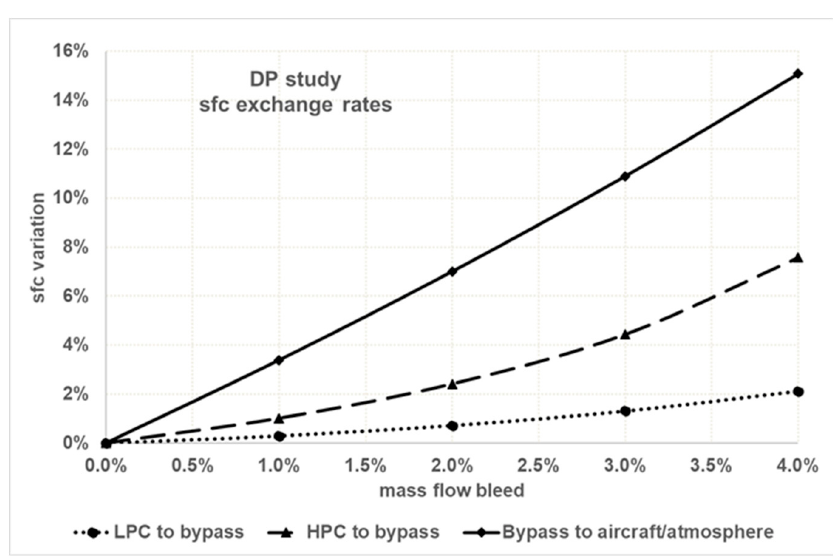
Figure 13. Bypass duct mass flow effect on SFC (DP study).